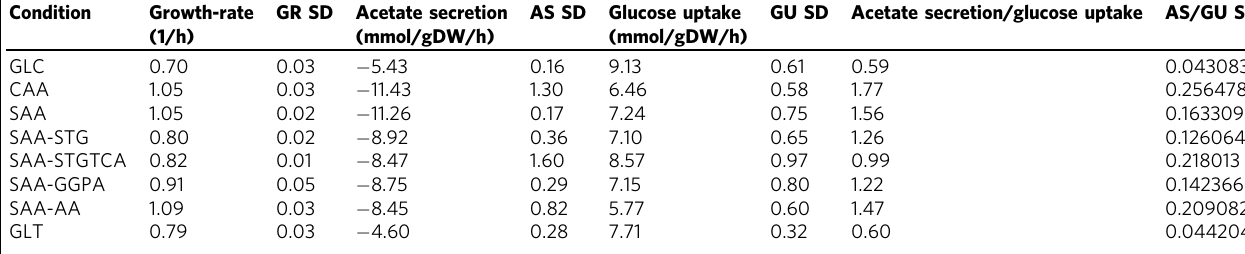
Table 1 Growth rate, glucose consumption, and acetate secretion rates of cell cultures grown with M9 glucose medium and SAA mixtures deprived of certain groups of amino acids Condition Growth-rate